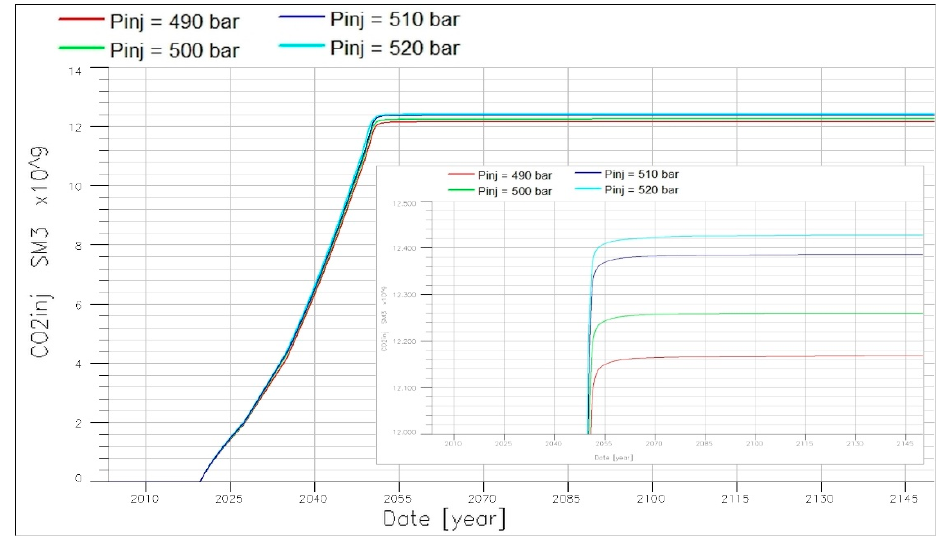
Figure 24. Total CO 2 injections for various injection scenarios.